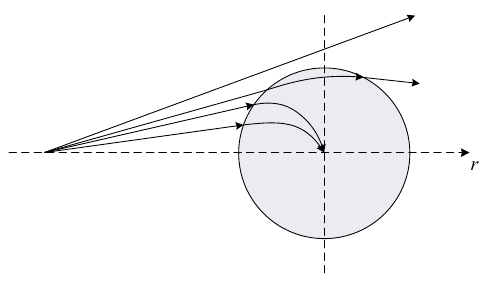
Figure 2: Propagation trajectory of bending wave in perfect acoustic black hole structure.